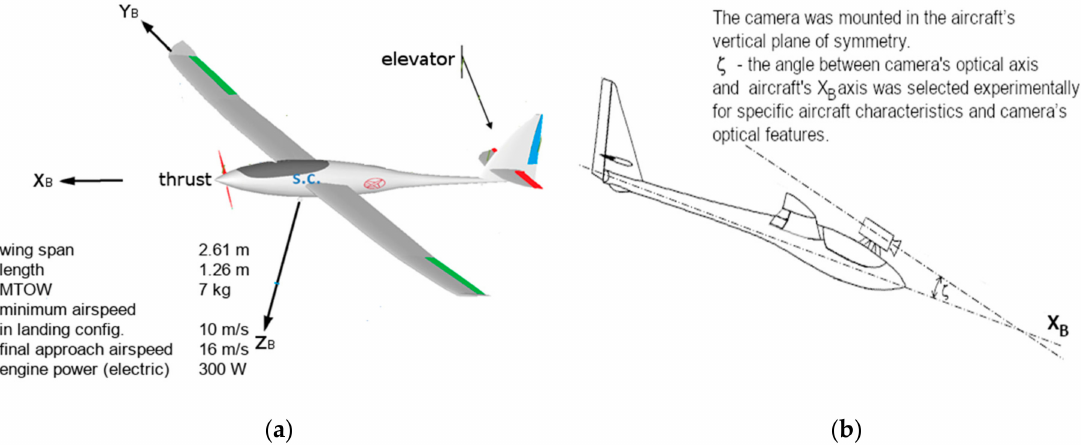
Figure 2. The experimental airplane used in research. ( a ) General overview and features; ( b ) orientation of the optical axis of camera in relation to the